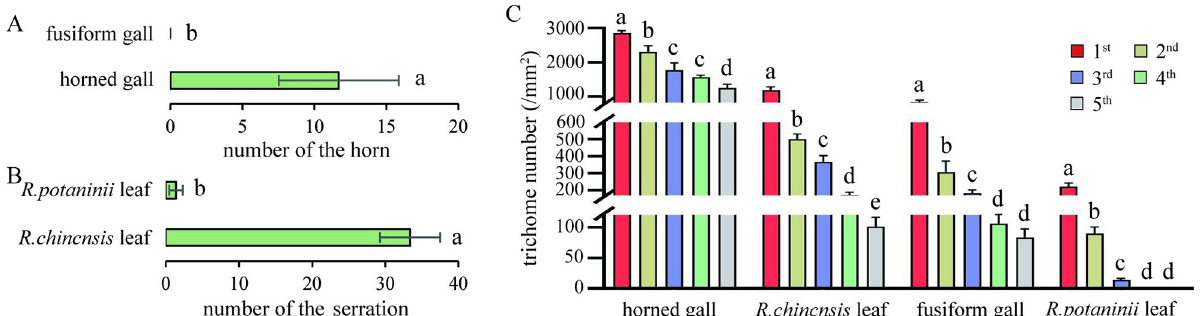
Fig 4. The number of horn, serration and trichome. A: The horn number of fusiform galls and horned galls. B: The serration number of R . potaninii leaflet and R . chinensis leaflet. C: The number of trichomes at different stages in the samples. P < 0.05.